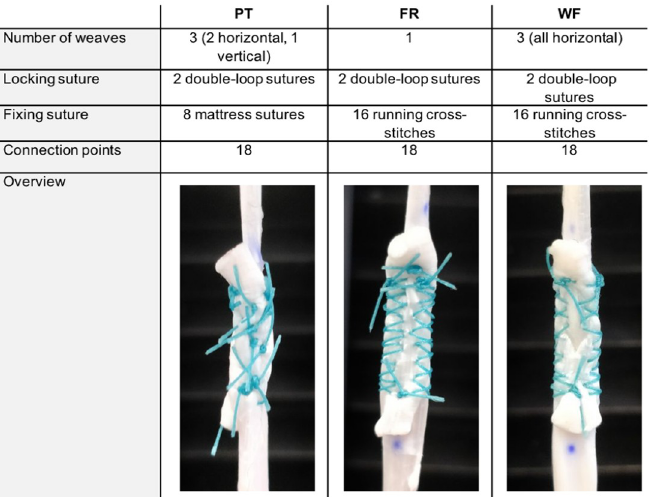
Fig 1. Overview of suture techniques used. The different techniques Pulvertaft (PT), Fride´n (FR) and Woven-Fride´n (WF) are illustrated: The donor tendon (above) was woven through incisions in the recipient tendon (below). For each suture technique the same amount of connection points between the tendons was used. The threads were cut in standardized fashion at 10 mm length.